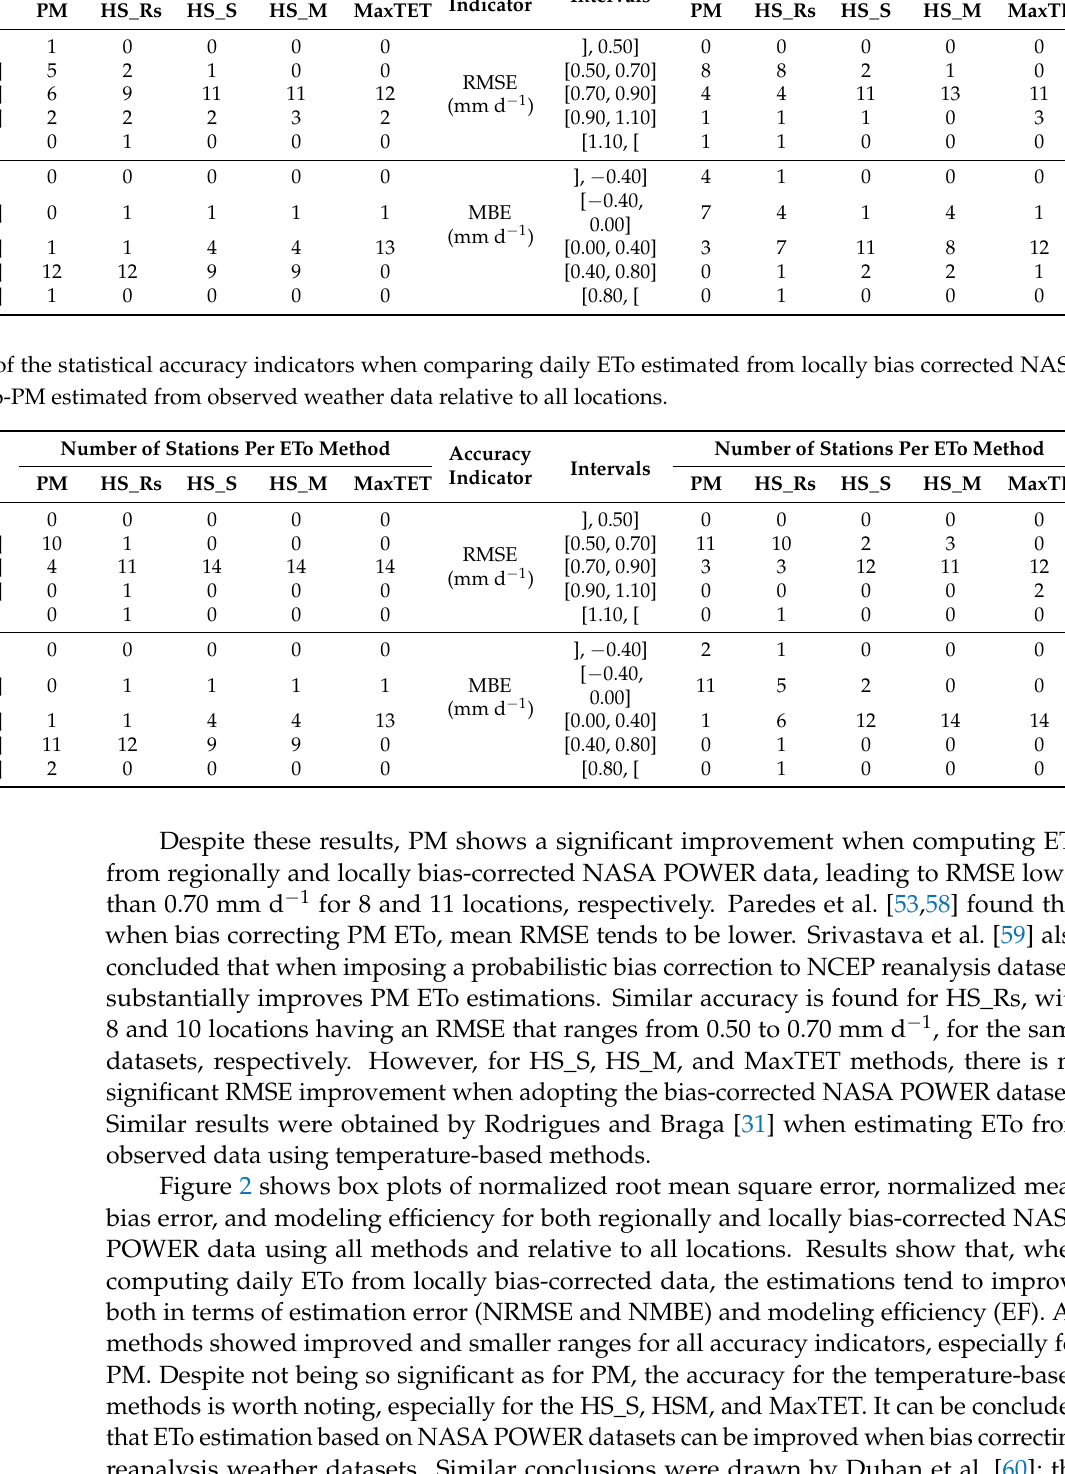
Table 4. Distribution of the statistical accuracy indicators when comparing daily ETo estimated from regionally bias corrected NASA POWER data with ETo-PM estimated from observed weather data relative to all locations. Accuracy Indicator